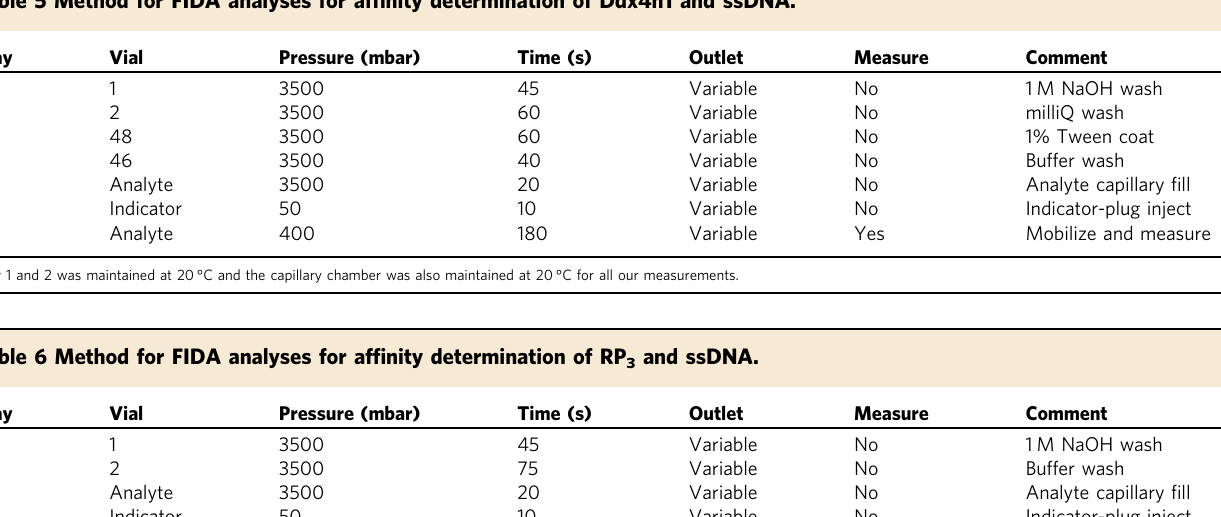
Table 5 Method for FIDA analyses for af fi nity determination of Ddx4n1 and ssDNA.